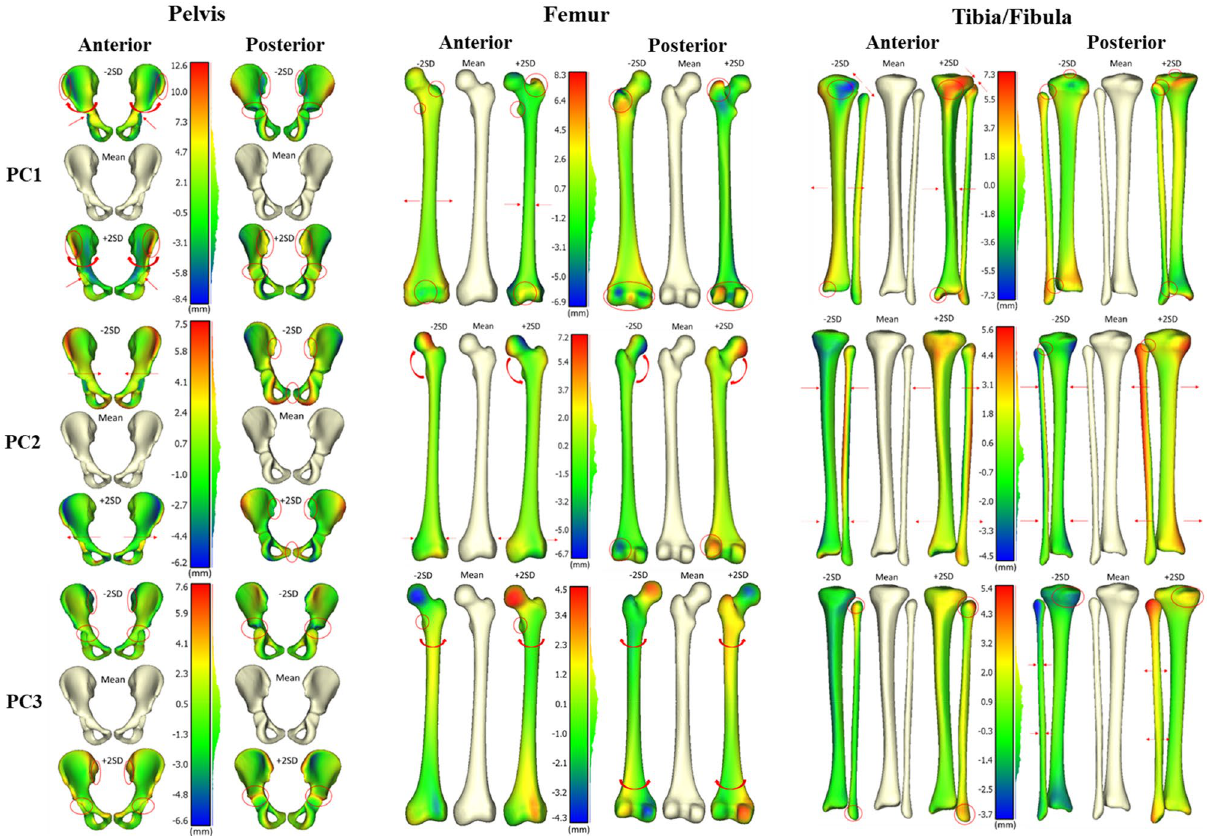
Figure 2. Coloured distance differences of mean meshes (cream) and ± 2SD for first three principal components following Procrustes analysis (i.e. shape variation only). Anterior (left) and posterior (right) viewpoints are shown and red ellipses and red arrows highlight main features of difference to the mean mesh.